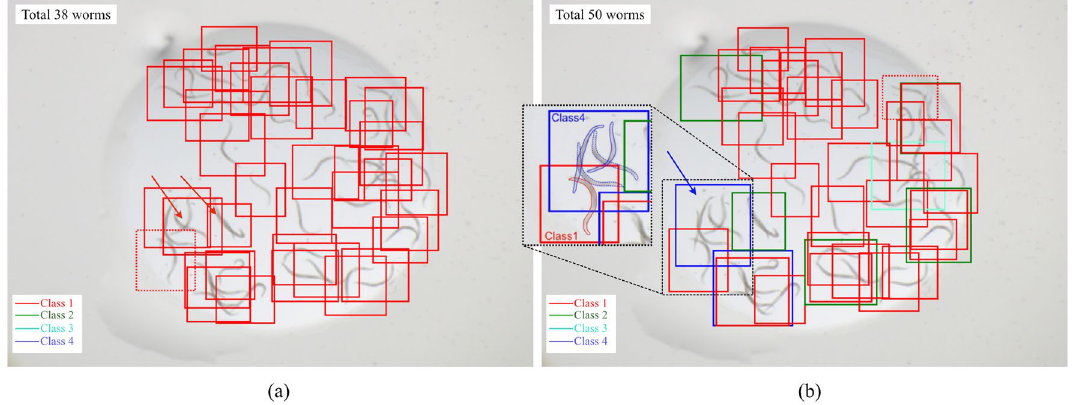
Figure 1. Results for the worm detections with ( a ) the one-class classification (OCC) and ( b ) the multi-class classification (MCC). Red, green, light blue, and blue bounding boxes show Class 1, Class 2, Class 3, and Class 4, respectively. The ground truth number of the worms was